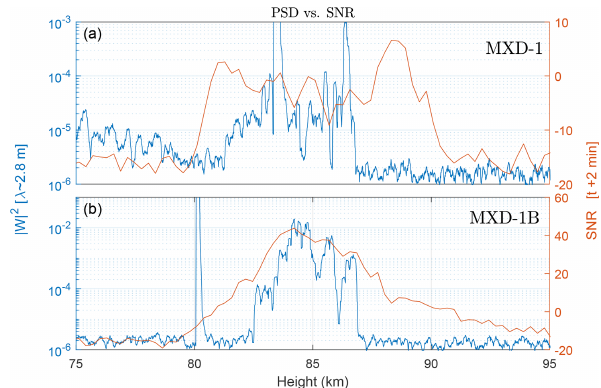
Figure 18. Comparison of MAARSY SNR (red, 2min after launch), and PSD from the wavelet transform of DUSTY bot- tom plate currents (blue), evaluated at a wavelength of ≈ 2 . 8m = λ Bragg . Panels (a) and (b) show the situation for the MXD-1 and MXD-1B launches respectively. Note the different scales for the two